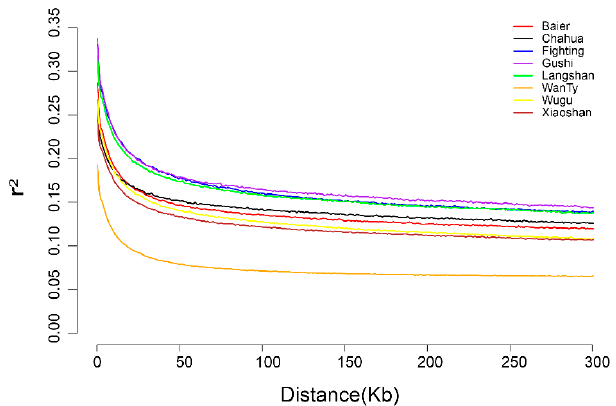
Figure 7. Linkage disequilibrium (LD, r2) decay for the eight Chinese native breeds. Genetic distance is measured in kilo base pair (kb). The effective population size (Ne) was estimated across the entire genome (Figure 8).